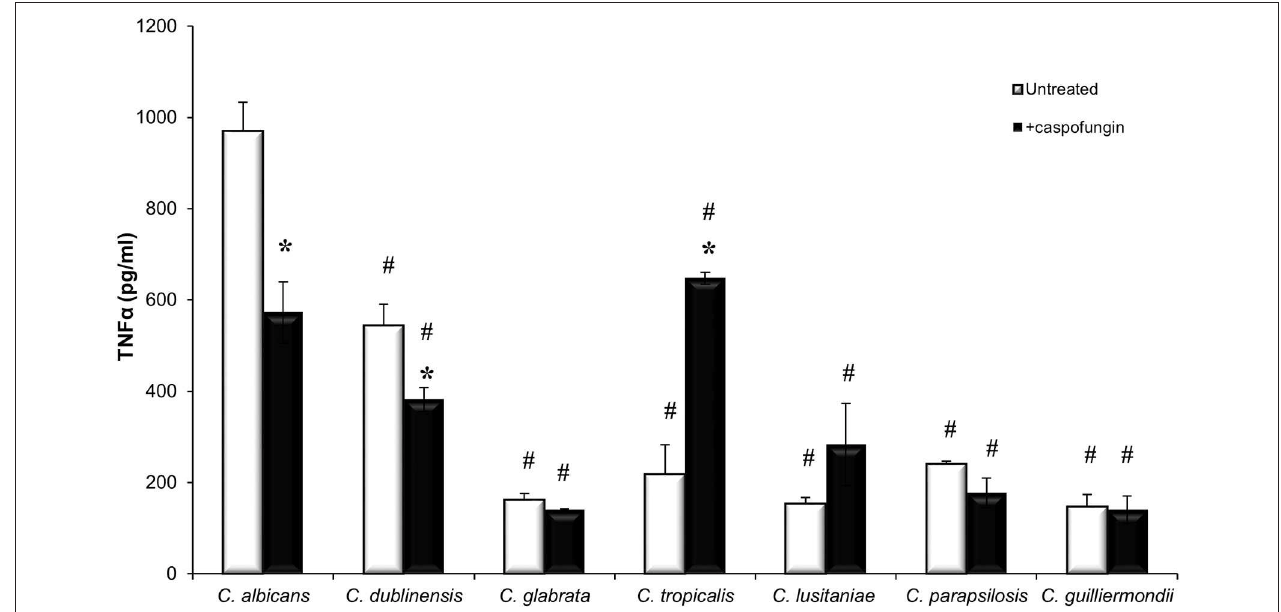
FIGURE 3 | Candida species stimulate different immune responses. Live cells of each Candida species, which had been grown with or without an IC 50 concentration of caspofungin for 6h, were exposed to J774 macrophages for 4h. After 4h of co-incubation, supernatants were collected and cytokine production was measured. Significant differences ( # p < 0.05) compared to C. albicans . Significant differences (* p < 0.05) compared to untreated cells of the same species. Error bars are SD ( n =